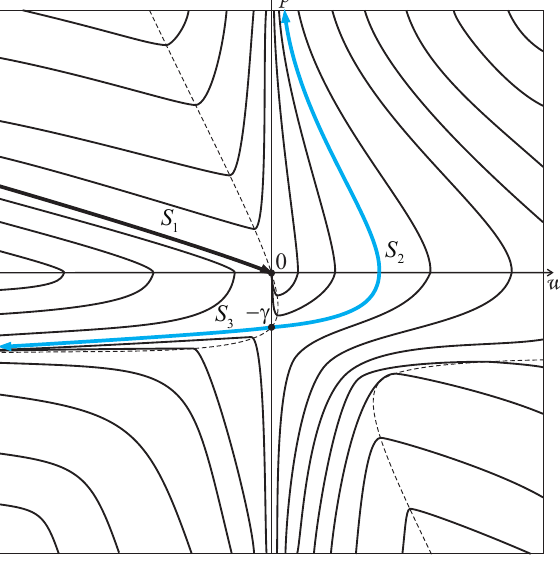
Figure 3. Phase portrait for γ < α . The properties of separatrices that do not coincide with the Op axis and the interpreta- tion of the results from the original problem point of view will be discussed